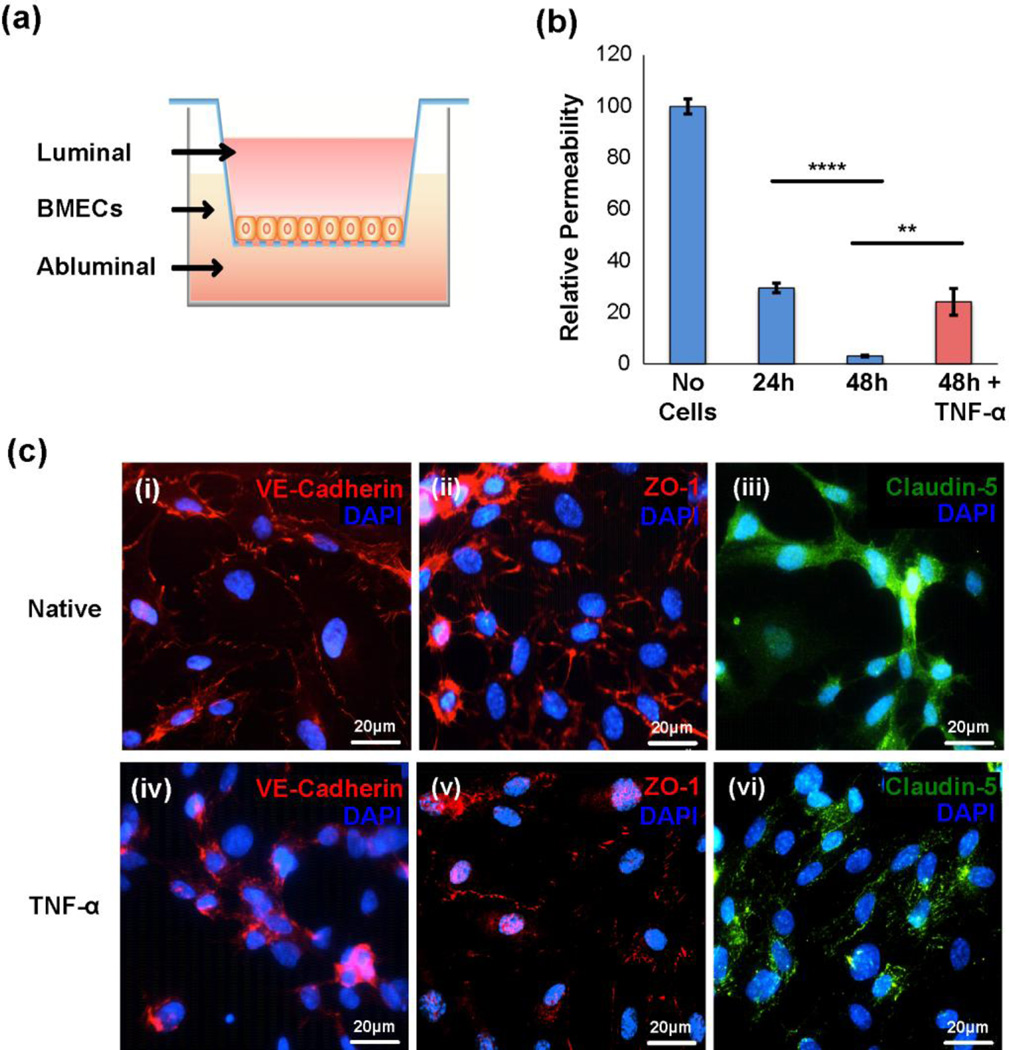
In vitro model of the BBB using BMEC monolayer indicated that stroke-like conditions increased its permeabilit y(a) The schematic representation of the in vitro model of BBB. (b) A BMECs monolayer was grown for 24 or 48 hours in a transwell insert, and then treated with TNF-α for 6 hours. Permeability was measured using FITC-dextran. BMECs formed a low permeability barrier after 48 hours, and permeability was increased significantly under TNF-α condition. Values represent as means ± SEM of relative ratio normalized to no cell control, set as 100%. **P < 0.01 and ****P < 0.0001 (c) Activation of BMECs with TNF-α regulates tight junction and adherens junction protein expressions in BMEC monolayer on coverglass. Immunofluorescence of VE-cadherin, ZO-1, and Claudin-5 showed that their expression levels were dramatically down-regulated after TNF-α treatment. DAPI was used for staining nuclei. Scale bar: 20 µm.